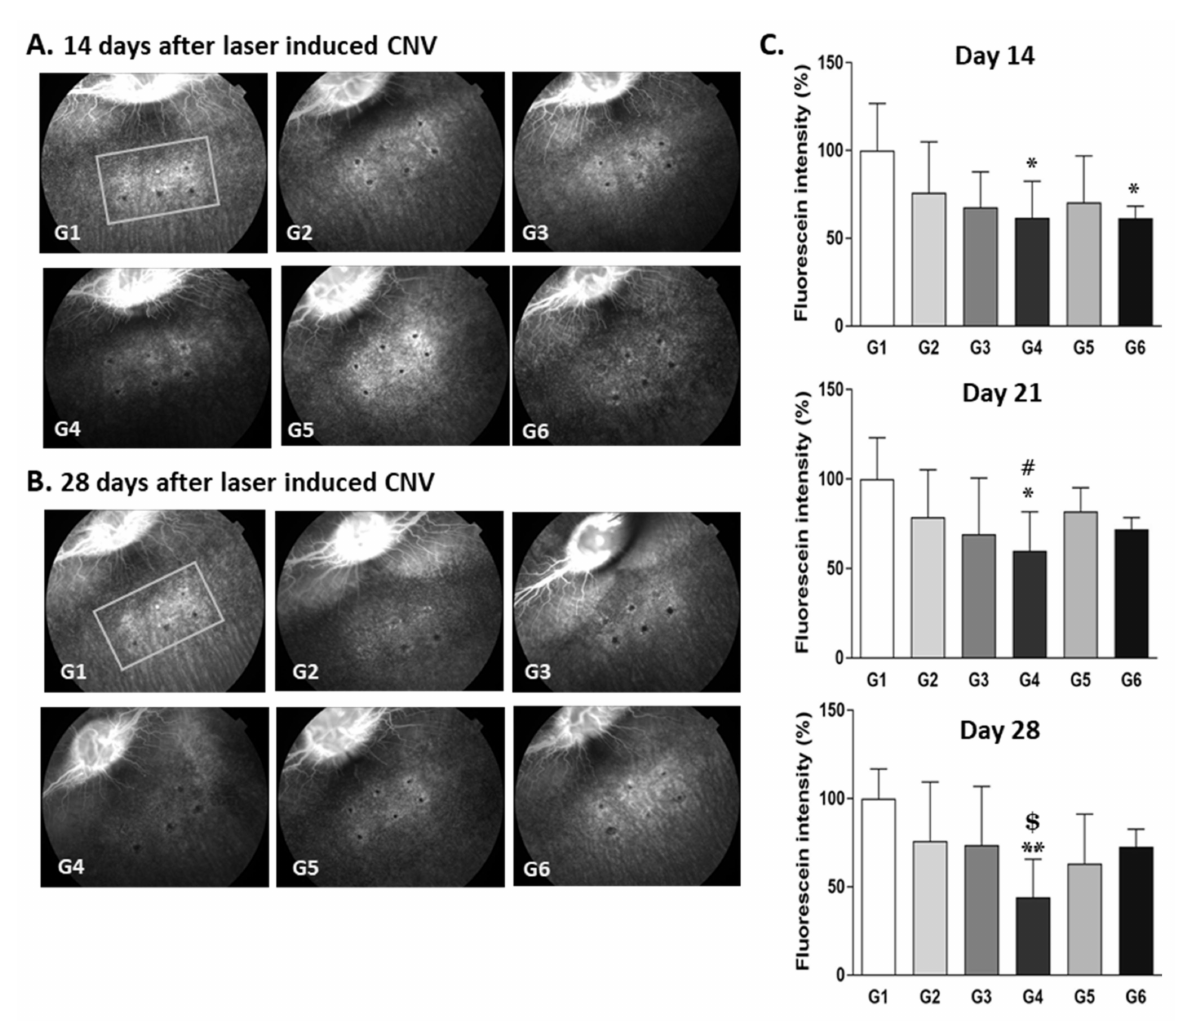
Figure 6. The effects of the intravitreal administration of Ac-RLYE, ranibizumab, and aflibercept on inhibition of choroidal neovascularization (CNV) in laser-induced CNV rabbit models with treatment of peptide or positive control at the same day as laser irradiation. The intensity of laser irradiation and spot size was empirically set in order to maintain the retinal fluorescence intensity in the vehicle treatment group at 4 weeks after laser irradiation. ( A , B ): Representative retinal fluorescence fundus image. ( C ): A quantitative image analysis result for retinal fluorescence intensity using the ImageJ software ( n = 7 rabbits per group). The day of laser irradiation was designated as day 0. Data are expressed as mean ± S.D. G1: Vehicle control, G2: Ac-RLYE 2 µ g/50 µ L/eye, G3: Ac-RLYE 20 µ g/50 µ L/eye, G4: Ac-RLYE 100 µ g/50 µ L/eye, G5: Ranibizumab 500 µ g/50 µ L/eye, G6: aflibercept 2000 µ g/50 µ L/eye. **/* A significant difference at p < 0.01/ p < 0.05 level compared to the G1. # A significant difference at p < 0.05 level compared to the G5 . $ A significant difference at p < 0.05 level compared to the G6. Compared to vehicle group (arbitrarily set at 100%, G1), the retinal fluorescence intensity in the Ac-RLYE groups was significantly decreased in a dose-dependent manner (G3, G4). At 21 and 28th days after administration of the test substance, retinal fluorescence intensity of the Ac-RLYE 100 µ g/eye treated group (G4) was significantly lower than that of the ranibizumab treated group (G5) or aflibercept treated group (G6), which suggest a superiority of Ac-RLYE over ranibizumab and aflibercept under this experiment